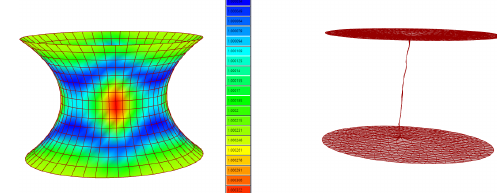
Figure 15: Comparison with SATS included